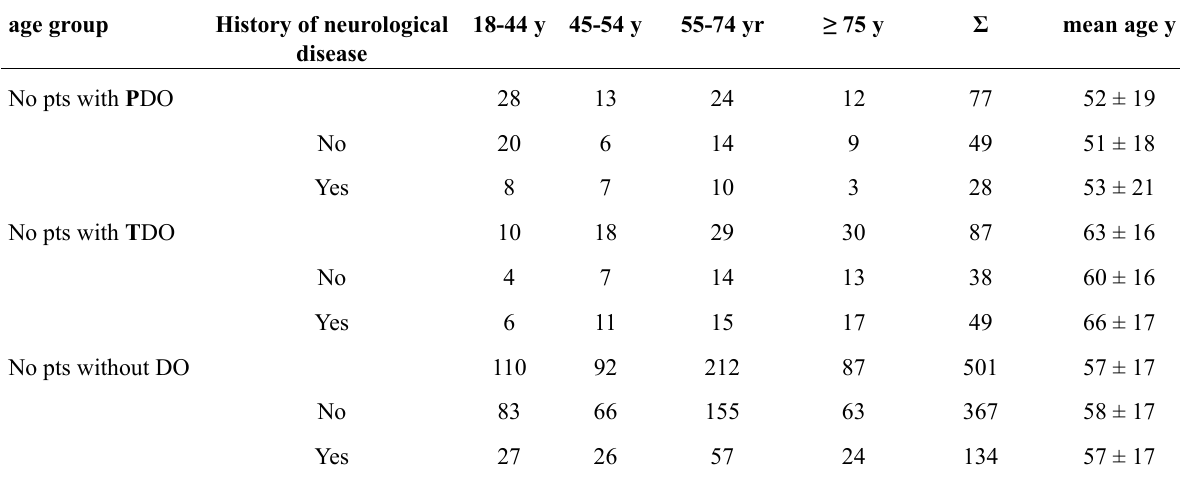
Table 2: Number of women in each age group. No difference in age between the 3 groups: PDO, TDO and no DO whatever the neurological